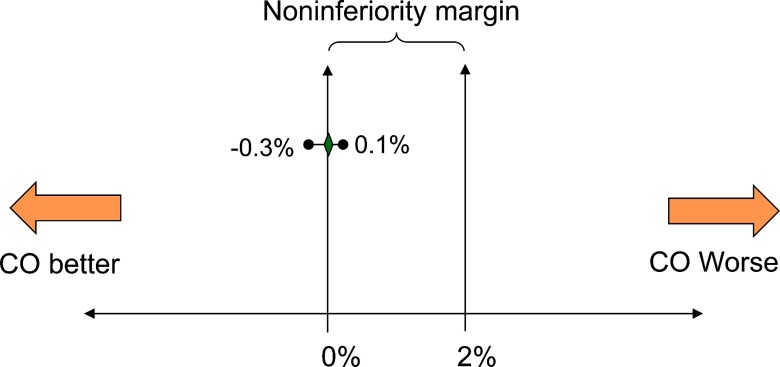
Interpretation of Risk Difference Between AMOs and COs for the Percentage of Women Experiencing a Major Adverse EventAbbreviations: AMO, assistant medical officer; CI, confidence interval; CO, clinical officer.The green diamond represents the point estimate of the risk difference (–0.1%) and the horizontal line to the left and right of the diamond represents the associated 2-sided 95% CI (–0.3%, 0.1%). Noninferiority of minilaparotomy performed by a CO is accepted because the upper limit of the 95% CI falls below the predefined noninferiority margin of 2%.